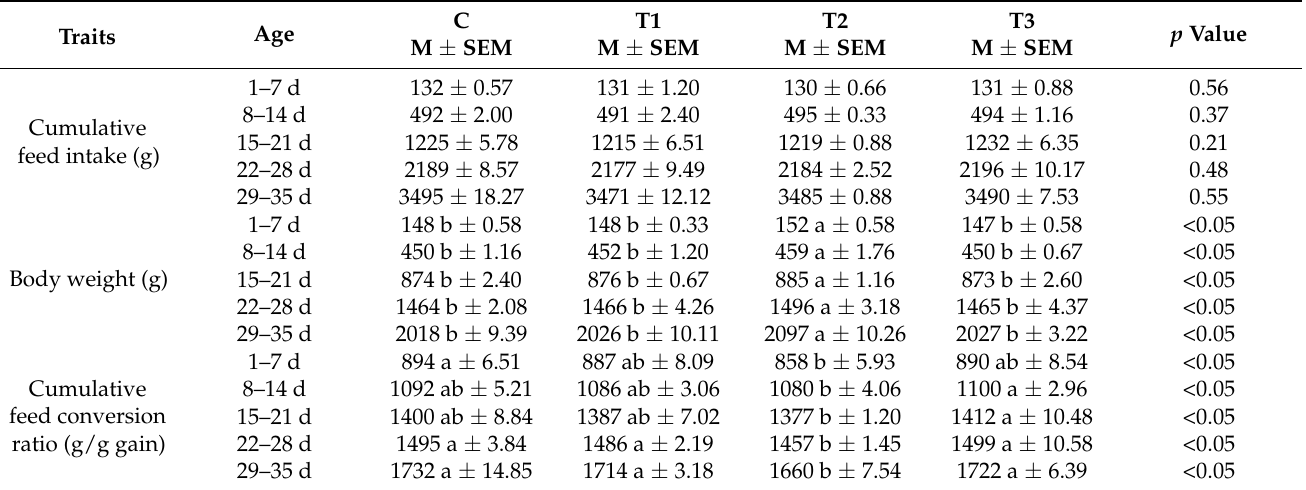
Table 4. Effects of black cumin seed meal and coconut meal on performance traits of broilers at different rearing